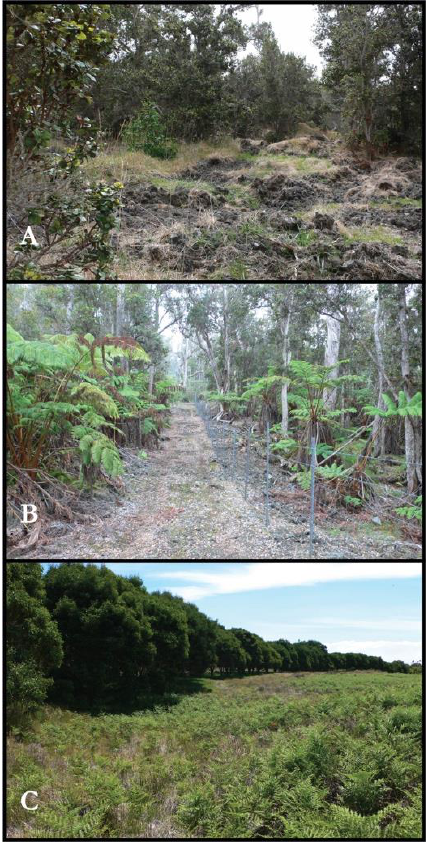
Figure 6. Restoration of native forest in Hawai`i requires significant up-front investments. ( A ) Scar- ification of land with a bulldozer (evident in the torn up soil) is often necessary to trigger koa seeds in the soil to germinate, now that the native birds that ate them, and in the digestive process opened their seed coats, are extinct. Sometimes mechanical or chemical interventions are needed to reduce non-native grass cover to give native tree seedlings a chance in competing for light and water; ( B ) Installation and maintenance of costly fencing is required to keep feral ungulates out of areas des- ignated for restoration; ( C ) Koa seedlings, germinated in a nursery, are planted in corridors such as this one several hundred meters long, in a design to facilitate future seed dispersal and forest regen- eration by birds ( PC Gretchen C. Daily, all photos ).